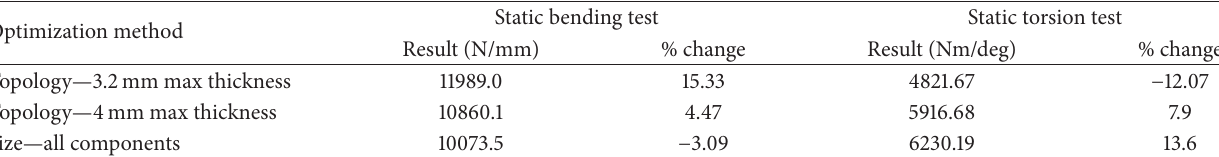
Table 6: Static test of models from optimization result.